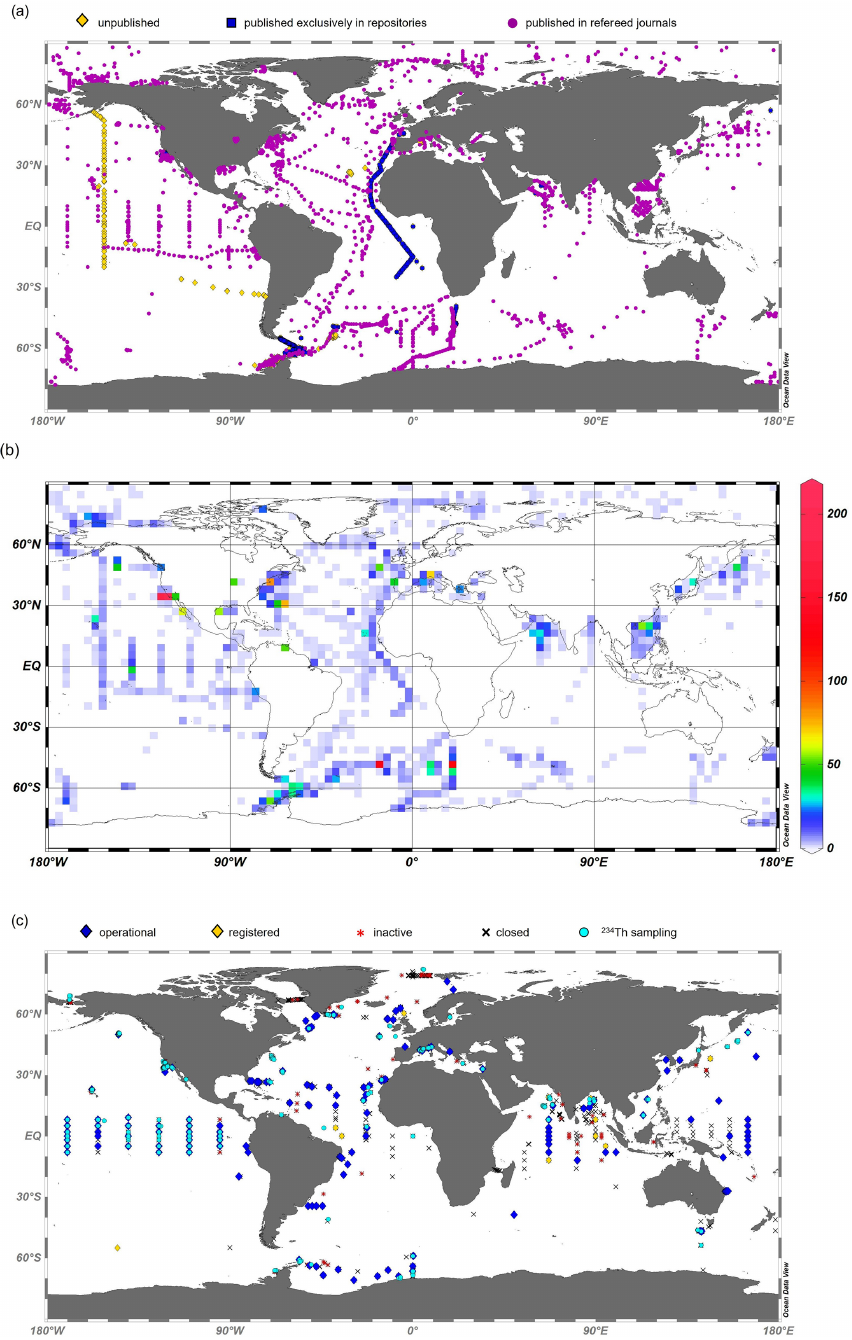
Figure 1. (a) Map showing the distribution of sampling stations catalogued as (i) unpublished (yellow diamonds), (ii) published exclusively in repositories (dark blue squares), and (iii) published in refereed journals (magenta dots). (b) Map showing data density by sampling location. (c) Map showing long-term, high-frequency time-series stations (TSSs) either (i) “operational” (blue diamonds), (ii) “registered” for future operation (yellow diamonds), (iii) “inactive” (red asterisks), or (iv) “close” (black crosses) (source: https://www.ocean-ops.org, last access: 1 June 2022) and those locations including 234 Th sampling that match a TSS (light blue